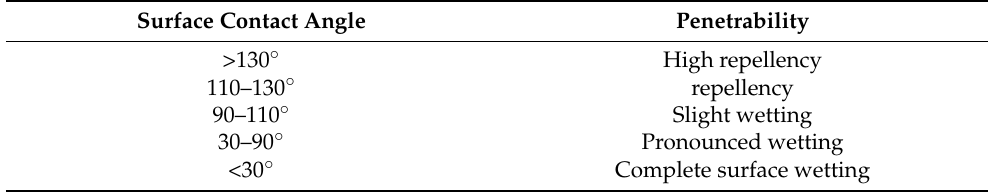
Table 3. Water penetrability according to the contact angle [40–44].